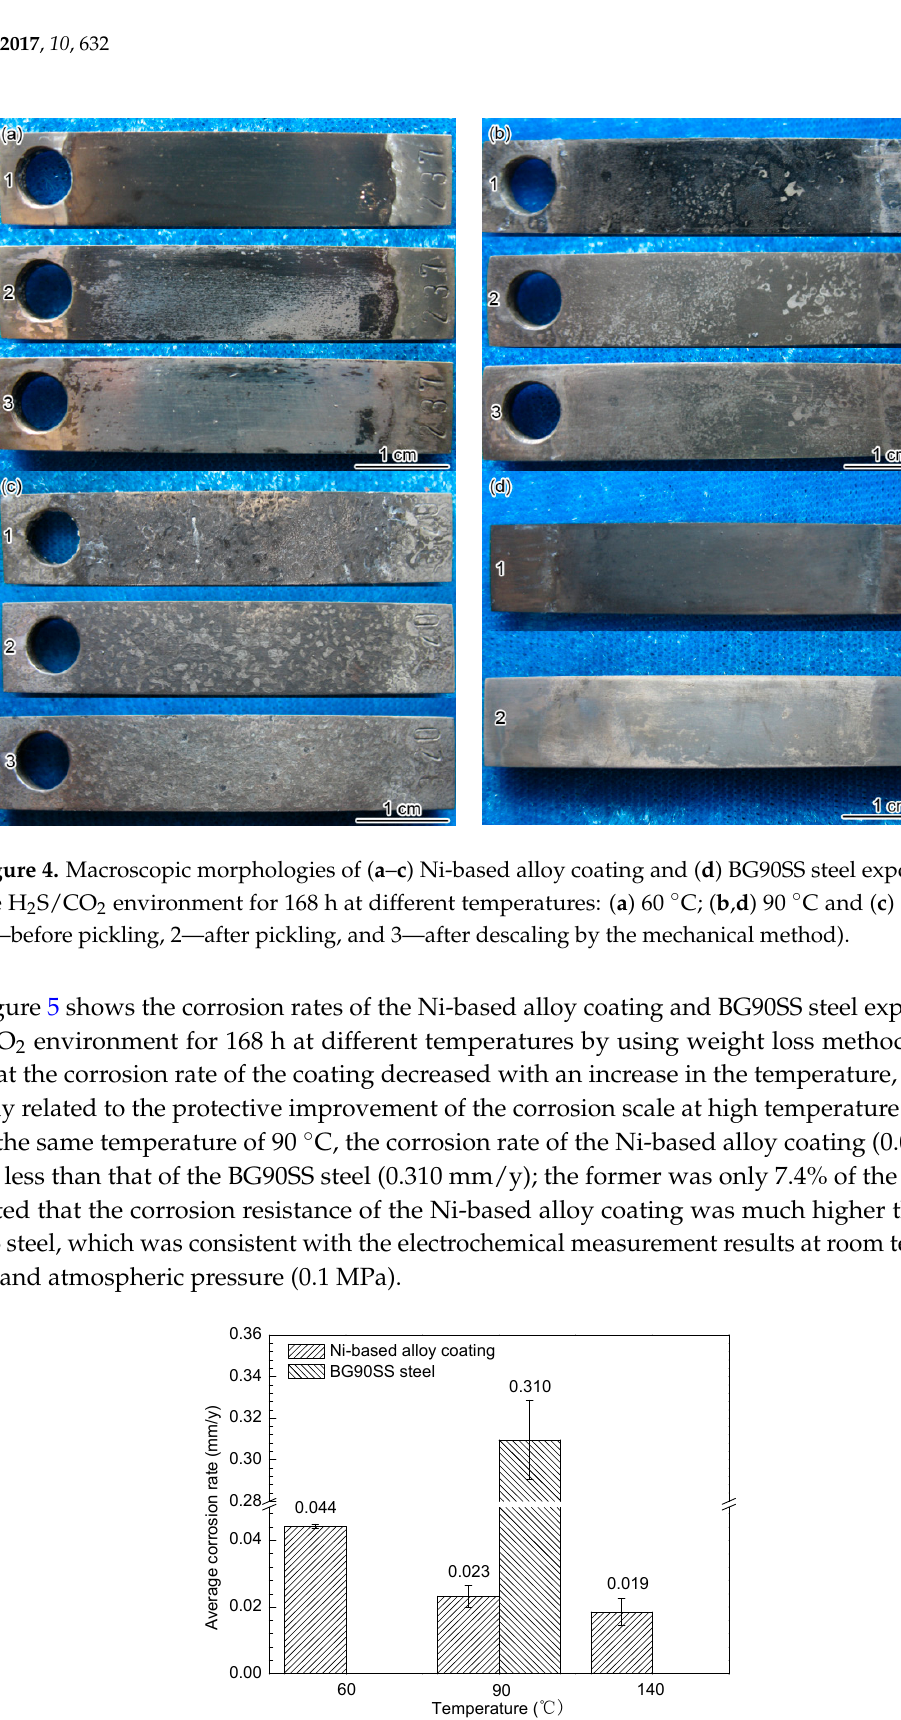
Figure 5. Corrosion rates of the Ni-based alloy coating and BG90SS steel exposed to the H 2 S/CO 2 environment for 168 h at different temperatures.